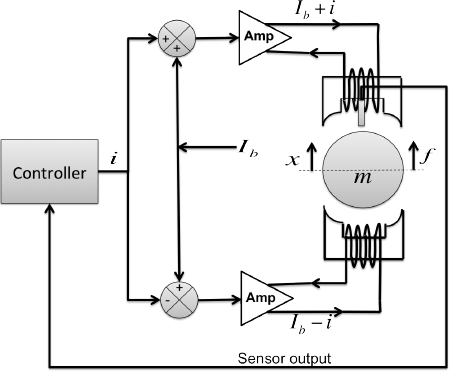
Figure 1. AMB system in one degree of freedom.